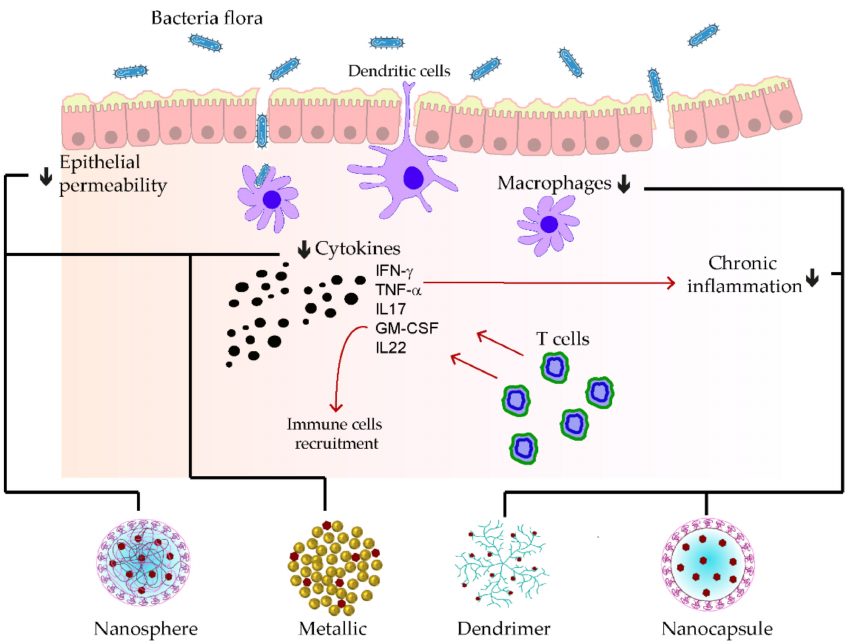
Figure 5. Examples of nanocarrier delivery of polyphenolics and their targets in inflammatory bowel disease. The black arrows up signify the increasing while the down ones indicate the decreasing effects. The red arrows stand for promotions. The black dots consist of inflammatory cytokines. The bold lines match the nanocarriers and their respective